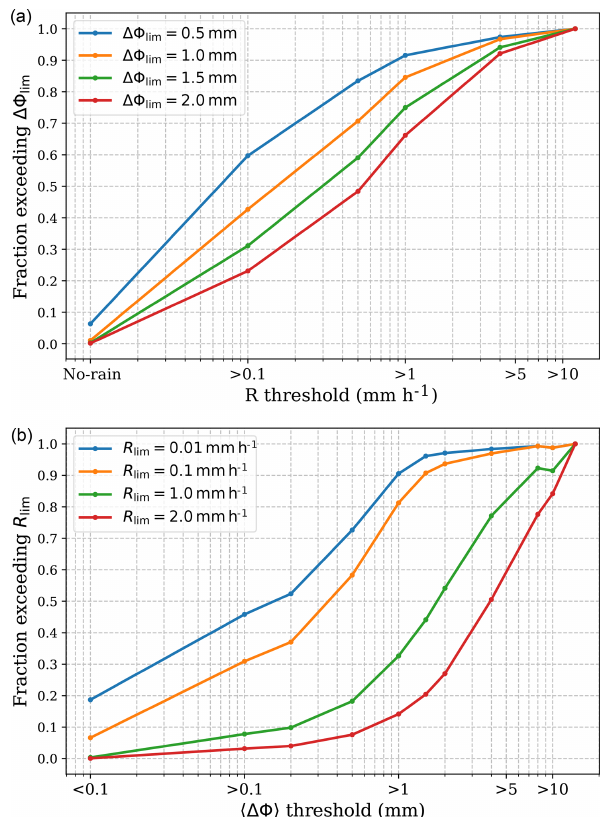
Figure 12. (a) Fraction of cases exceeding certain (cid:104) (cid:49)(cid:56) (cid:105) 0–10km value (blue: 0.5mm; orange: 1.0mm; green: 1.5mm; and red: 2.0mm) as a function of the associated precipitation threshold.